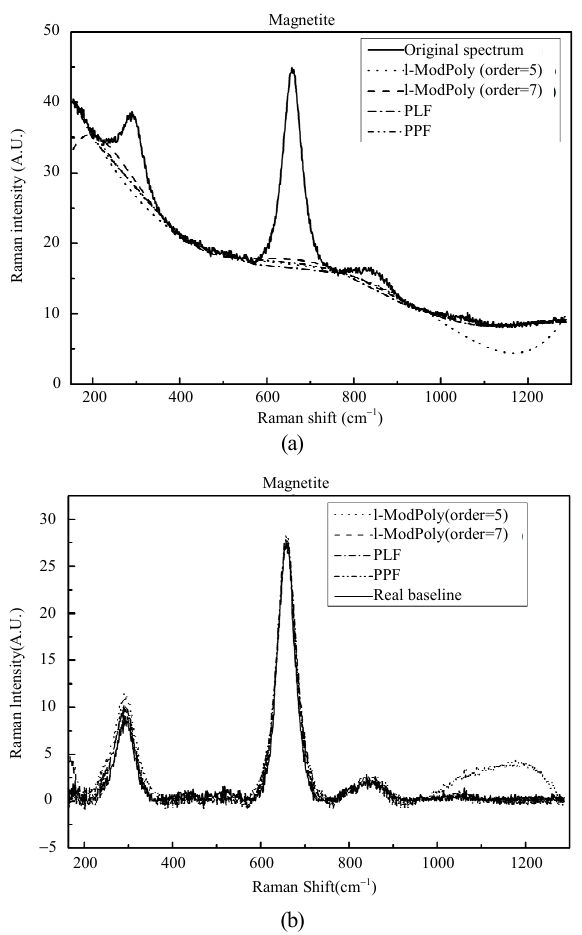
Fig. 8 Baseline correction for magnetite : (a) the original spectra and the background and (b) final pure Raman spectra fitted by the three different methods in the appropriate